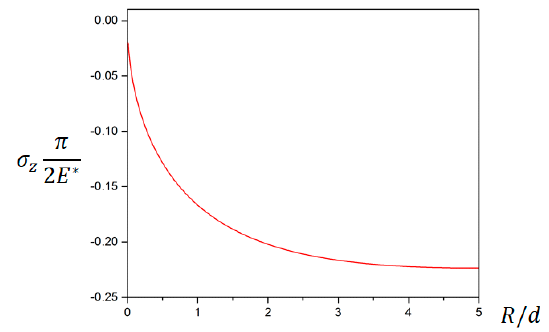
Figure 4. The relationship between z normal stress and curvature radius when z = 5d.